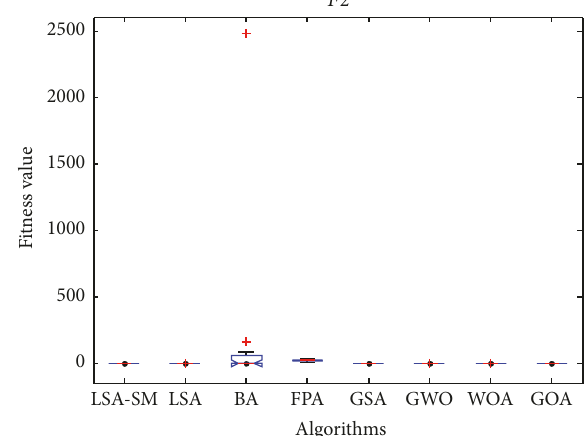
Figure 24: 𝐷 = 30 , ANOVA test of global minimum for 𝑓 02 .